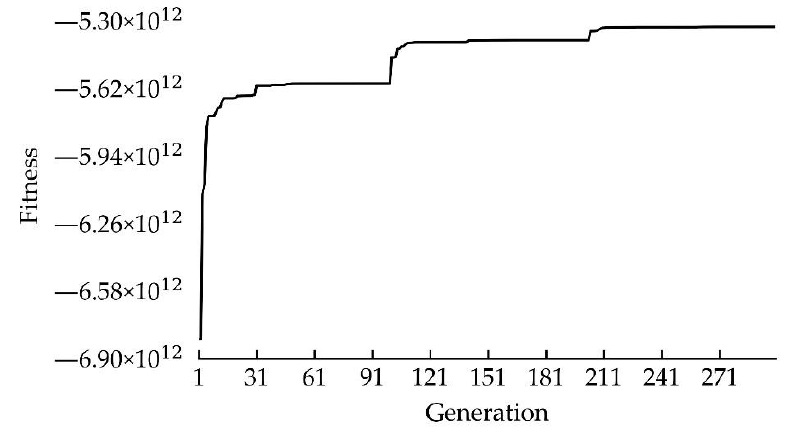
Figure 4. Evolution process using firm power initial solution for all states. Table 2. Simulation results of operation rules obtained by these two methods.